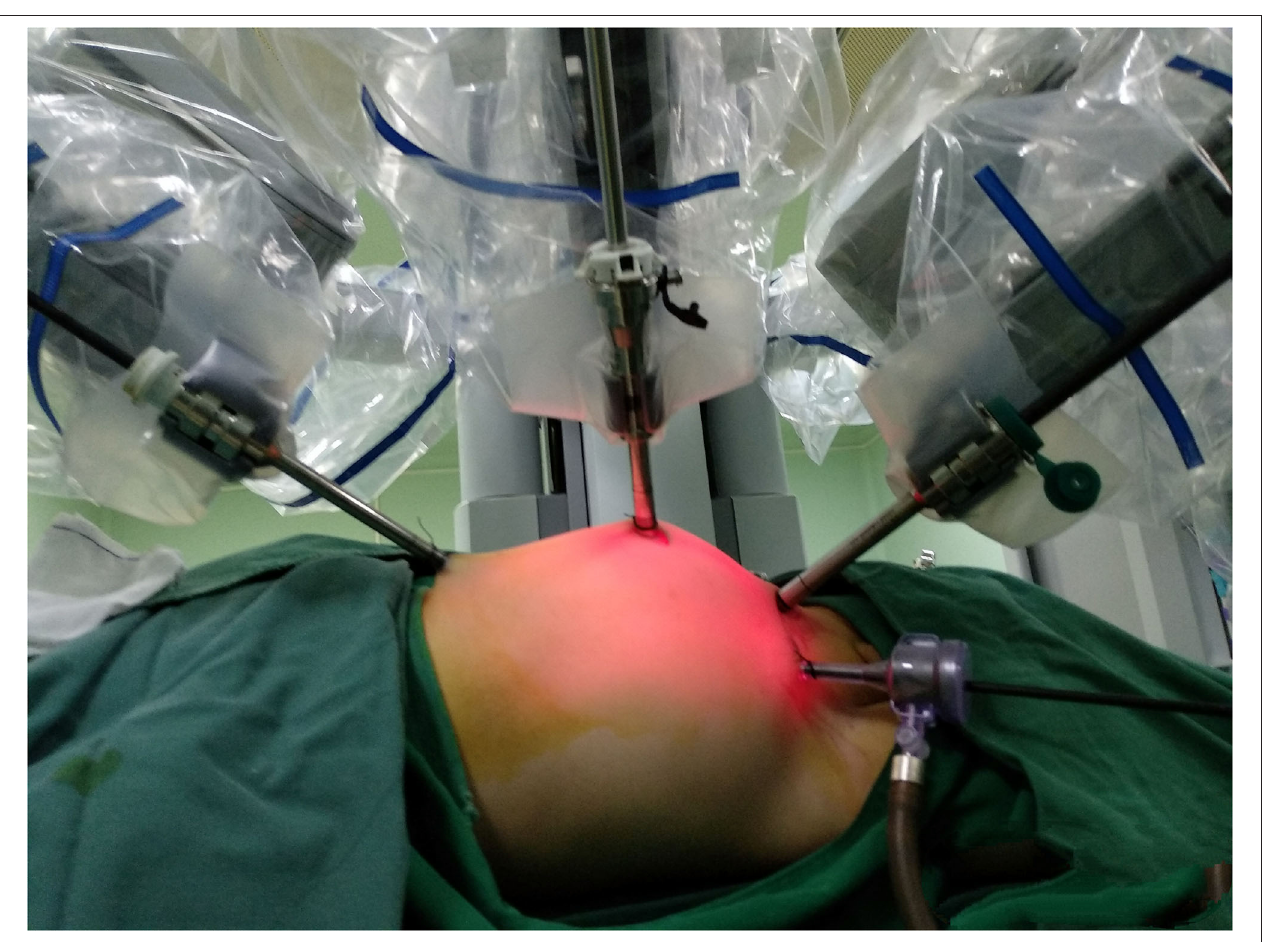
FIGURE 2 | Trocar position